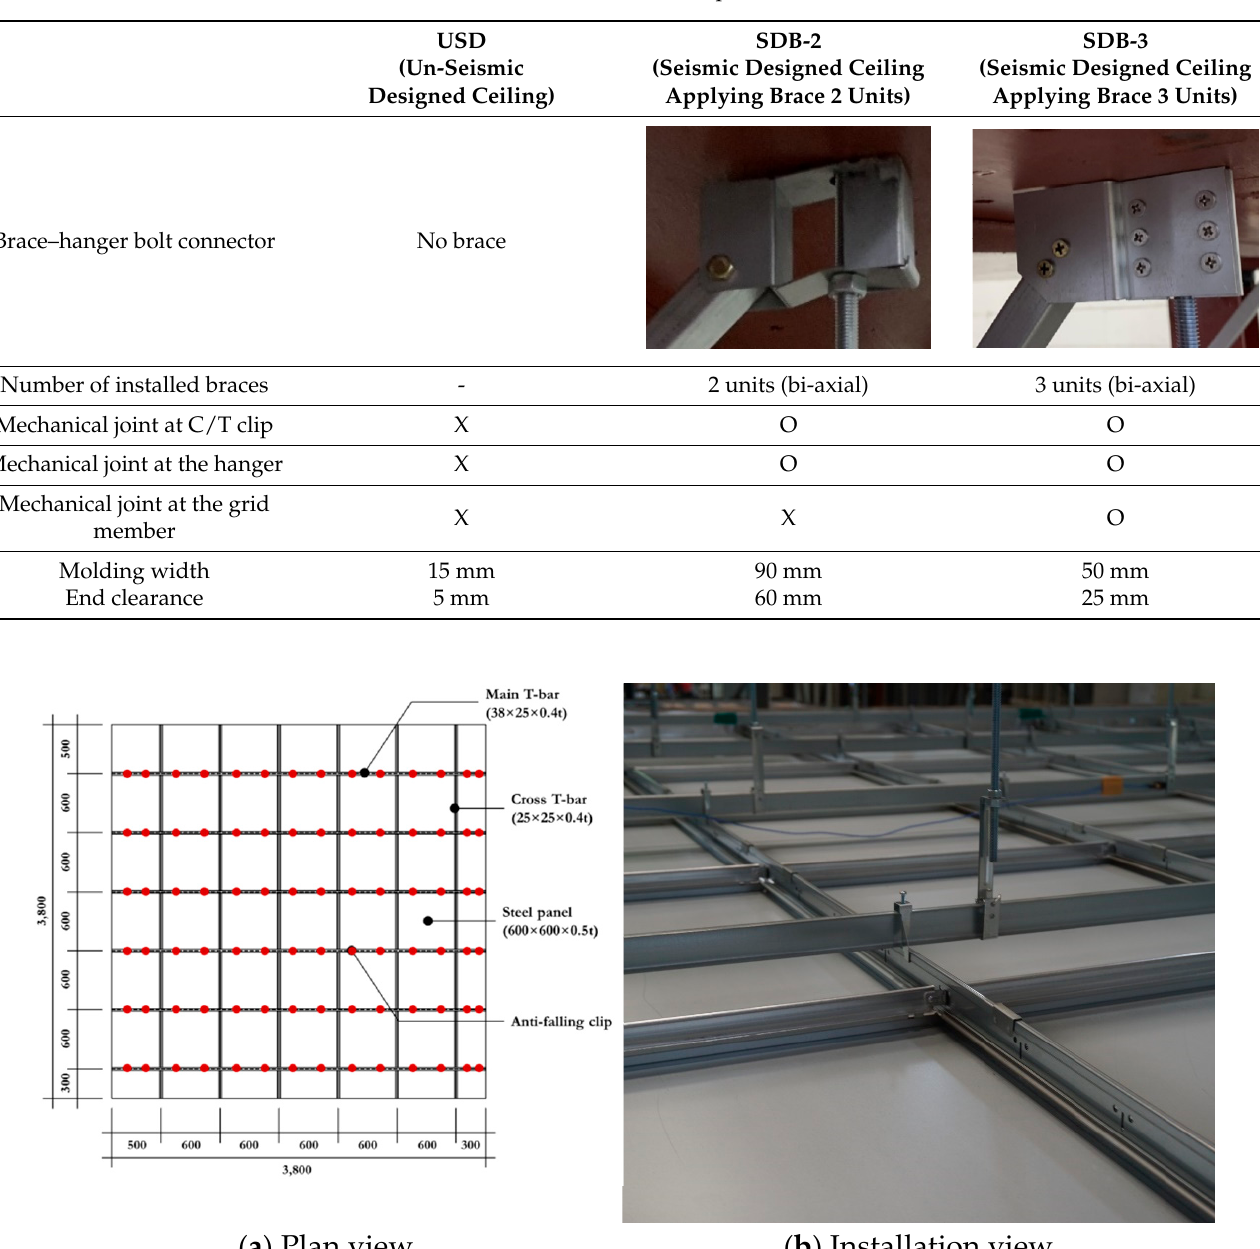
Table 2. Information of the specimens.